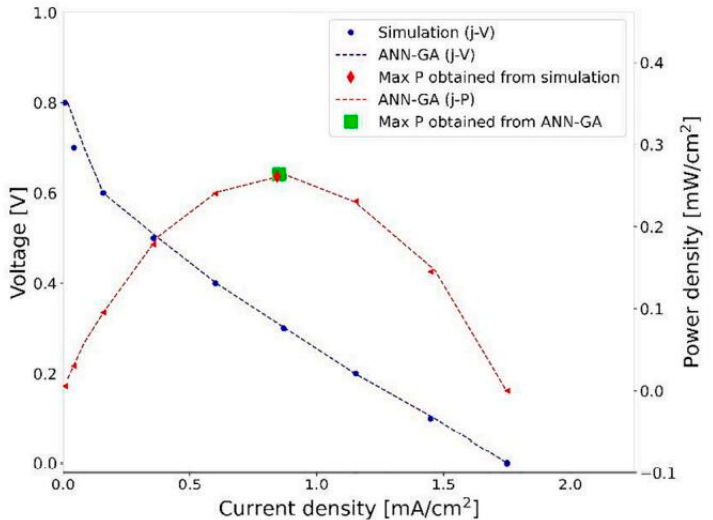
Figure 15. Comparison of the polarization curves predicted by ANN-GA and calculated by the 3D multiphysics simulation under the GA-indicated optimal operating condition that leads to the maximum power density (j: current density; V: cell voltage; P: power density; ANN: artificial neural network; GA: genetic algorithm) [110].